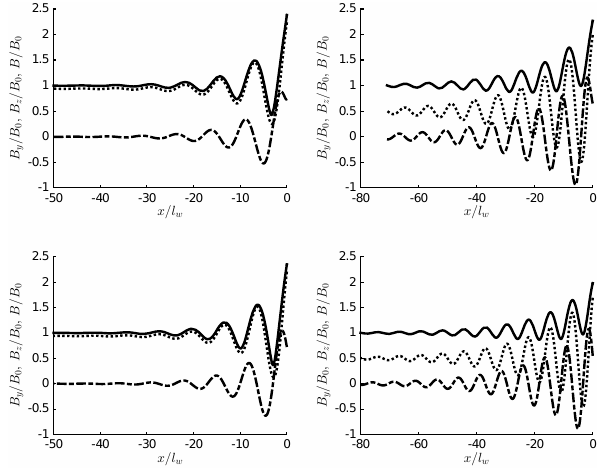
Figure 1. The total magnetic field (solid line) and the two perpen- dicular components, B z /B 0 (dotted) and B y /B 0 (dash-dotted) for the four cases: 1) θ = 70 ◦ , β = 0 . 2, M = 2 . 14 (top left); 2) θ = 30 ◦ , β = 0 . 2, M = 2 . 05 (top right); 3) θ = 70 ◦ , β = 1 . 2, M = 2 . 79 (bot- tom left); and 4) θ = 30 ◦ , β = 1 . 2, M = 2 . 14 (bottom right). In all cases the fast Mach number M F = 2.